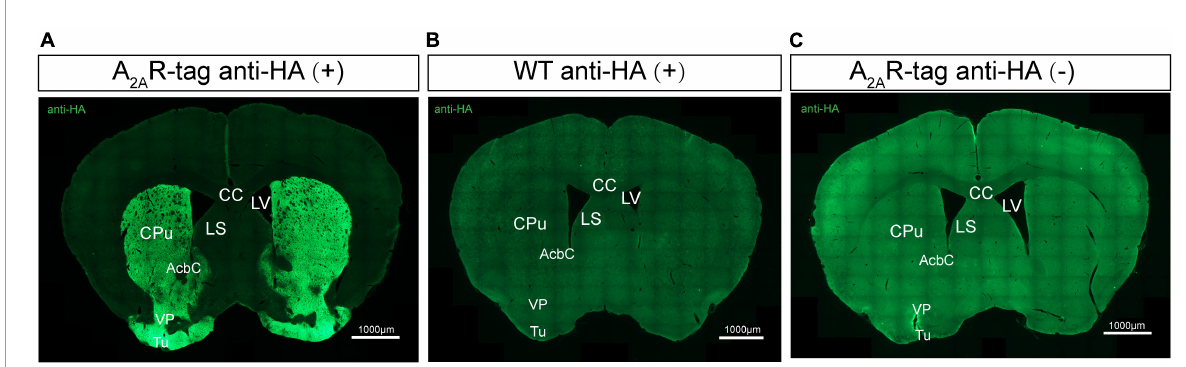
FIGURE3 Evaluation of the specific HA expression in adult adenosine A 2 A receptor (A 2A R)-tag mice. (A) Coronal brain sections of A 2A R-tag were incubated with an anti-HA antibody, and the most prominent and intense labeling was observed in the neuropil of the entire striatum and extended into the nucleus accumbens and olfactory tubercles. (B) There was no signal that could be detected in brain slices from wild-type mice after incubating with an anti-HA antibody. (C) Without adding an anti-HA antibody, there is no detectable staining signaling on brain slices